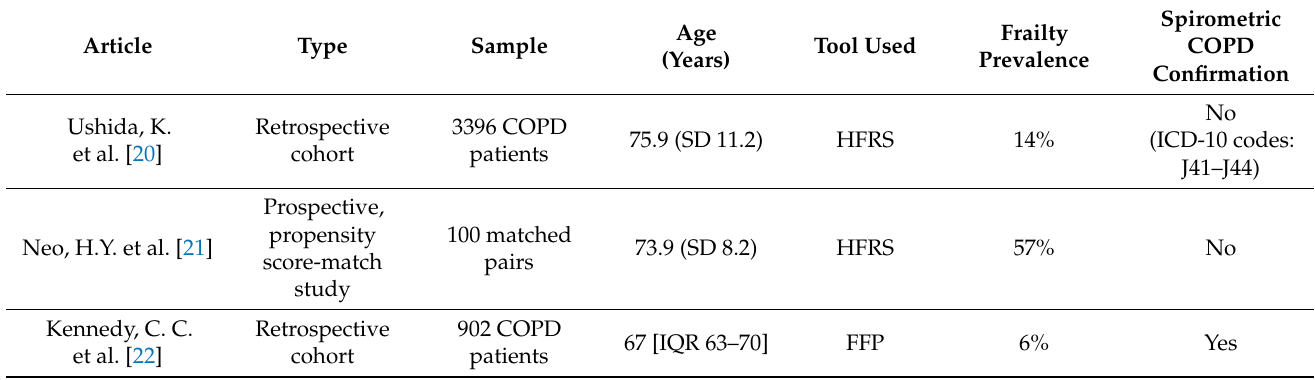
Table 1. Summary of studies with reported prevalence of frailty in COPD